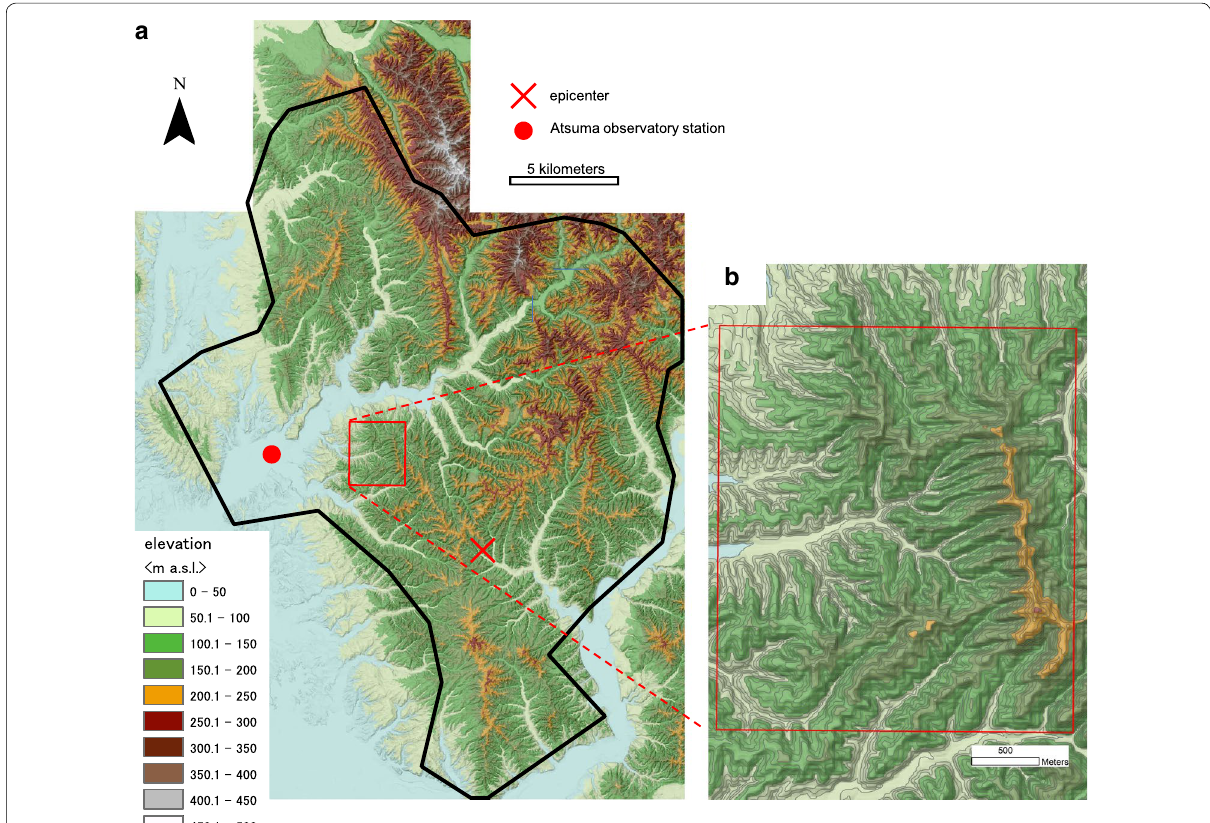
Fig. 1 Study area. The area affected by landslides was 440 km 2 (enclosed by black line). b Enlarged image of the area framed in red in a . Contour interval is 10 m. The figure was composed based on a 10-m digital elevation model (DEM) provided by the Geospatial Information Authority of Japan (GSI)